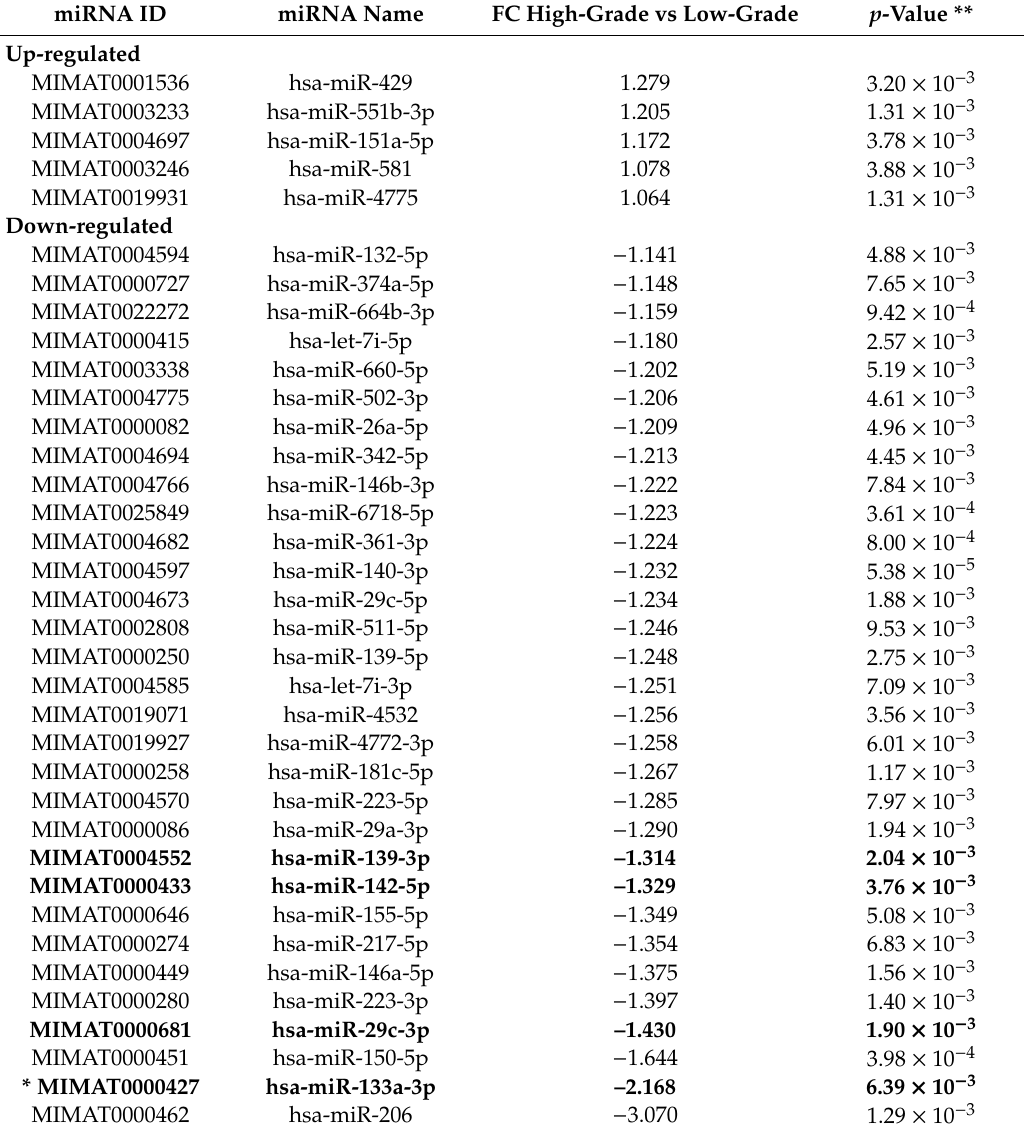
Table 5. TCGA analysis of up-regulated and down-regulated miRNAs in high-grade compared with low-grade